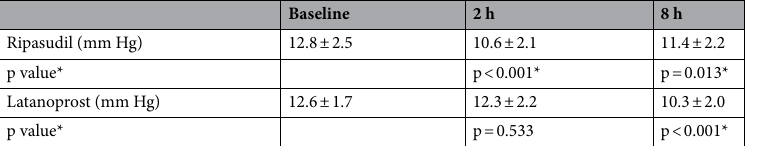
Baseline 2 h 8 h Ripasudil (mm Hg) 12.8 ±